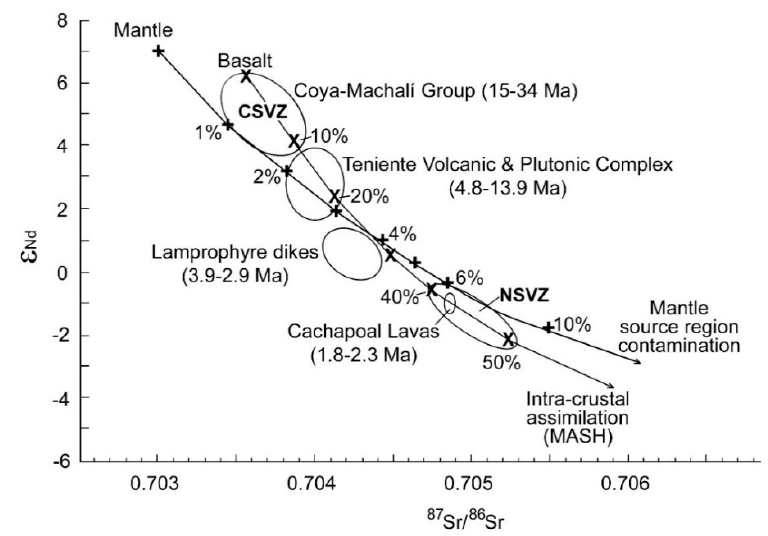
Figure 4. Sr versus Nd isotopic values of the various groups of igneous rocks of different ages in a transect across the Andes at the latitude of El Teniente (34° S; [10,14,17,21–24]). The figure illustrates both a source region contamination model of primitive mantle (+’s, Sr = 36 ppm with 8 7Sr/ 86 Sr = 0.703 and Nd = 1.8 ppm with ε Nd = +7; [21]) mixed with various proportion of subducted crust and sediment (Sr = 380 ppm with 87 Sr/ 86 Sr = 0.70763 and Nd = 42.3 ppm with ε Nd = − 5.1), and also a MASH model for a Coya-Machalí basalt (x’s, Sr = 450 ppm with 87 Sr/ 86 Sr = 0.7035 and Nd = 9 ppm with ε Nd = +6) assimilating various proportion of Paleozoic-Triassic Andean granite basement (Sr = 350 ppm with 87 Sr/ 86 Sr = 0.7075 and Nd = 20 ppm with ε Nd = − 6; [10]) Both models reproduce the isotopic compositions of the progressively younger rocks in the transect, but the latter model requires assimilation of unacceptably high proportions of granite crust and is inconsistent with generation of primitive low SiO 2 olivine-bearing mafic rocks in each age group (Figure 5), as well as the progressively higher Sr content of the sequentially younger rocks, which is due instead to decreasing degrees of partial mantle melting [3–5,10] associated with decreasing volume of magmas erupted through time at this latitude in the Andes. (Reprinted from Geologic Society of American Bulletin, volume 117, Kay, S.M. et al., Episodic arc magmatism, crustal thickening, subduction erosion, and magmatism in the south-central Andes, page 78, Copyright 2005, with fair use permission from the Geologic Society of America.).